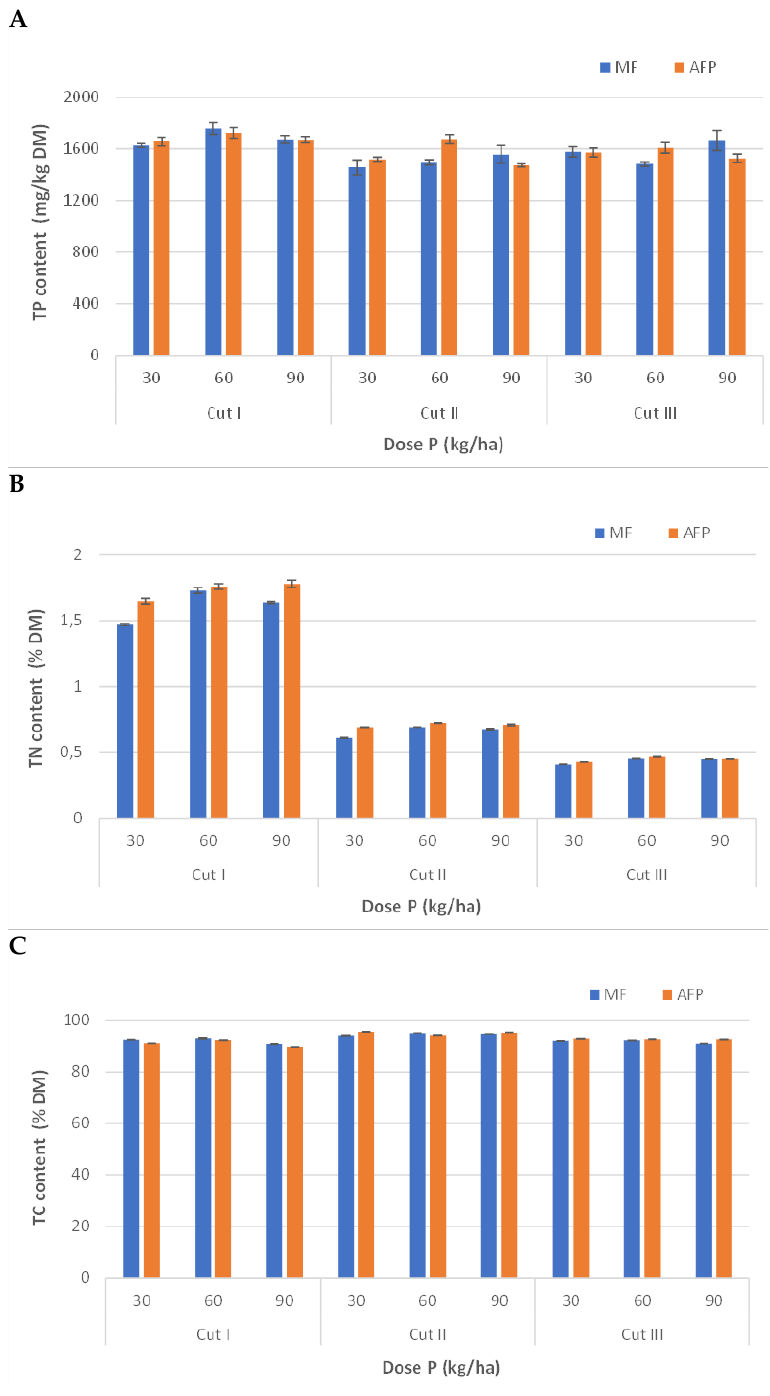
Figure 3. The content of phosphorus, nitrogen and carbon in Italian ryegrass depending on the cut cut and the type and amount of fertilization (( A )—TP content; ( B )—TN content; ( C )—TC content). and the type and amount of fertilization (( A ) — TP content; ( B ) — TN content; ( C ) — TC content). MF — MF—mineral fertilizer, AFP—hydrogel capsules with adsorbed mineral fertilizer, AFP — hydrogel capsules with adsorbed P.